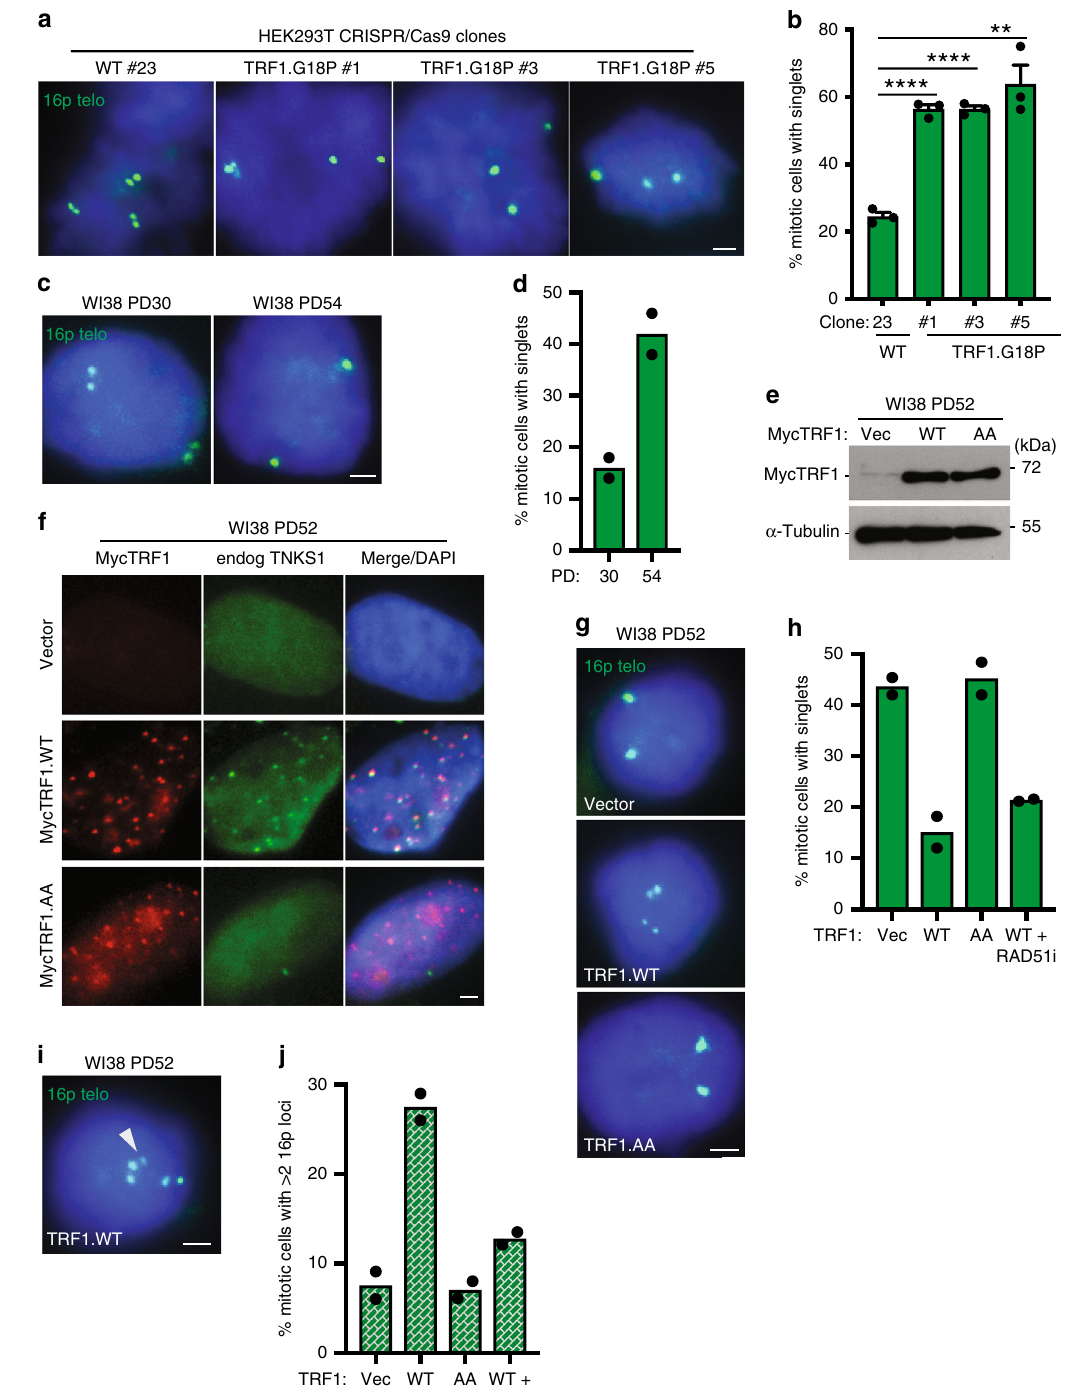
Resolution of cohesion triggers subtelomere recombination . Previous studies showed that forcing resolution of cohesion in ALT cancer cells led to RAD51-dependent subtelomere recom- bination between nonhomologous sisters evidenced by an increase in the number of 16p subtelomere loci 31 . FISH analysis indicated an increase in the frequency of mitotic cells with greater than two 16p loci in aged WI38 cells transfected with TRF1.WT, but not Vector or TRF1.AA (Fig. 1I, J), indicating that forced resolution of cohesion leads to subtelomere recombination in aged cells. Similar results were obtained in aged IMR90 cells